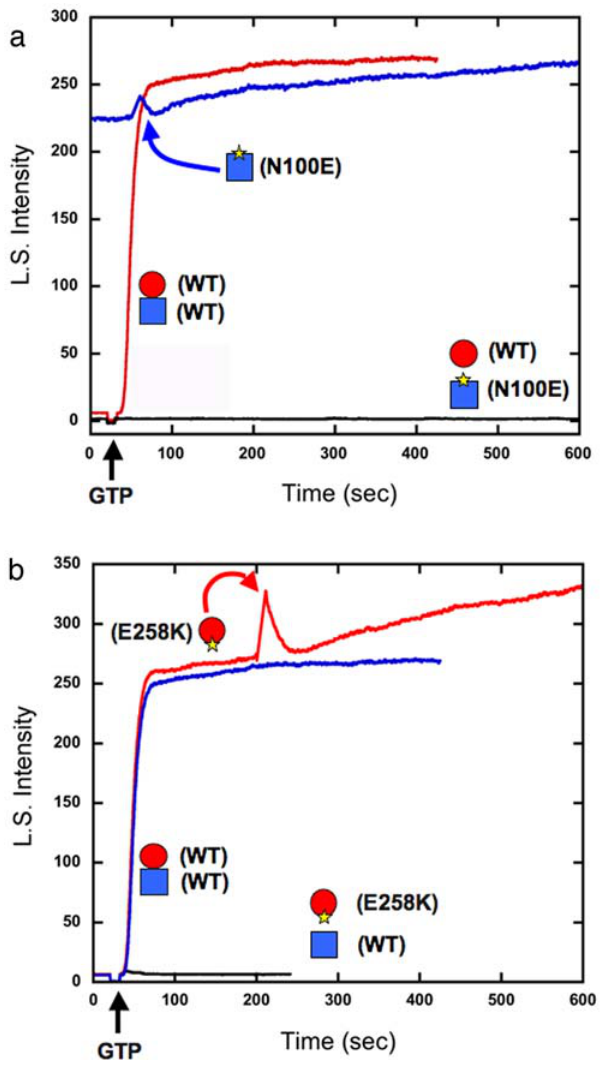
Figure 4. Within-dimer mutants fail to assemble but have no effect on pre-assembled wild type polymers. (a) Within-dimer mutant BtubB-N100E did not assemble when mixed with wild type BtubA (black line). When added to pre-assembled wild type polymer (all subunits at 5 m M) it did not cause any disassembly (blue line). (b) Within-dimer mutant BtubA-E258K behaved the same as BtubB-N100 in both assays.